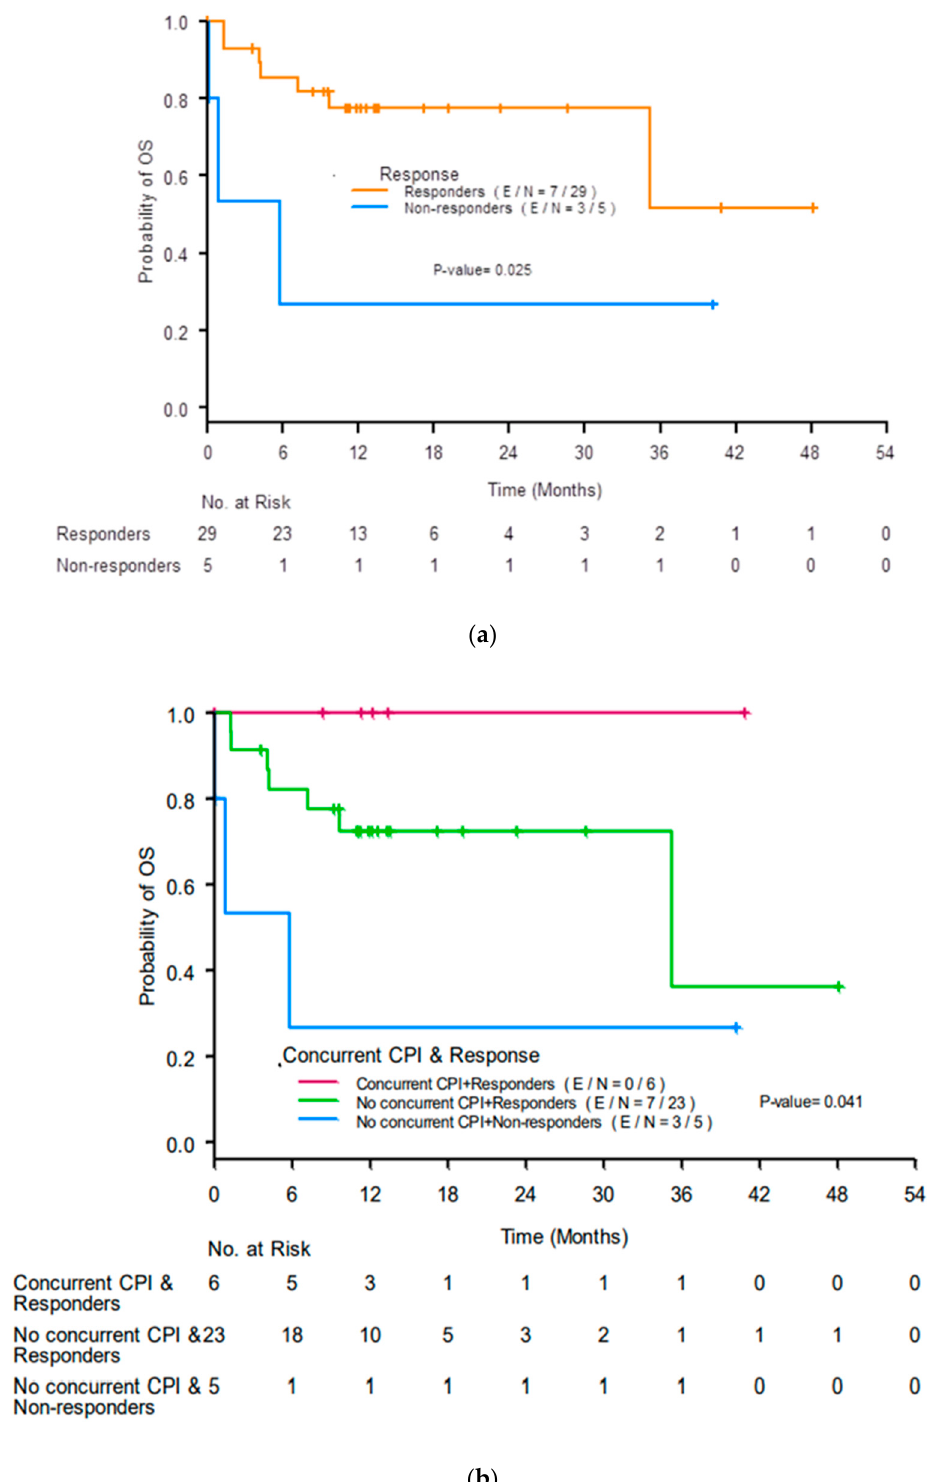
Figure 3. Kaplan-Meier curves for overall survival (OS) by ( a ) response to treatment for acute interstitial nephritis at 3 months after initiation of treatment and ( b ) renal response and use of concurrent immune checkpoint inhibitors (ICIs). CR, complete response; PR, partial response; NR, no response.